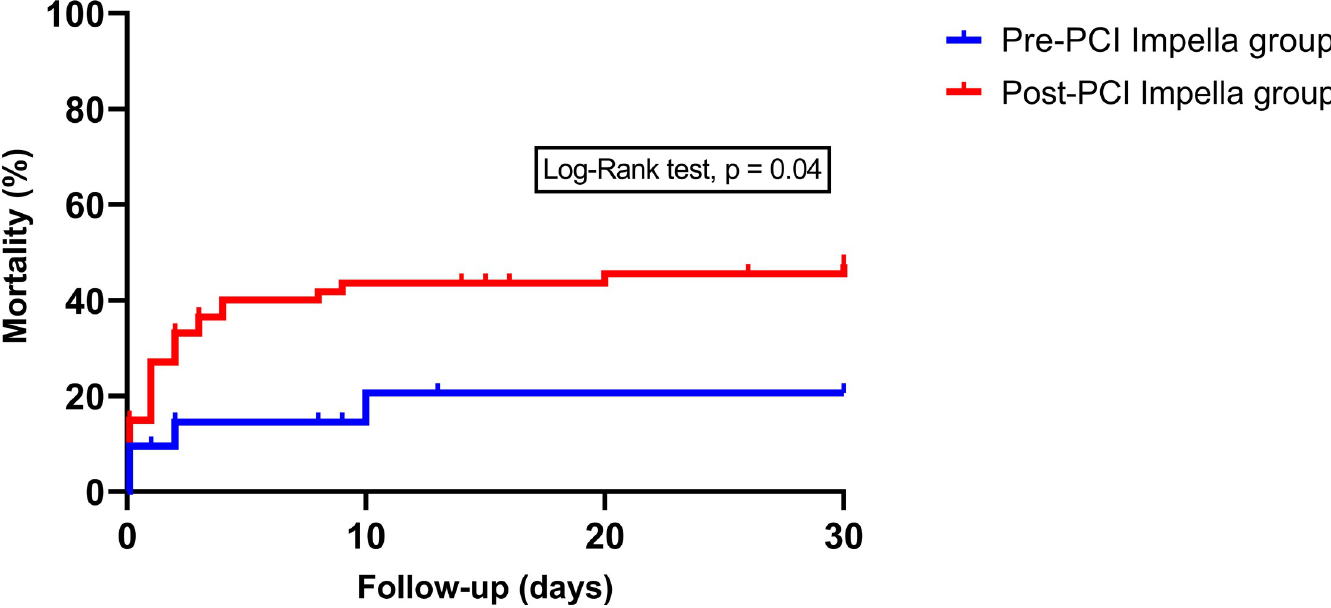
Fig 2. Short term cardiac mortality in AMICS patients treated with primary PCI and pre- versus post-PCI Impella support.